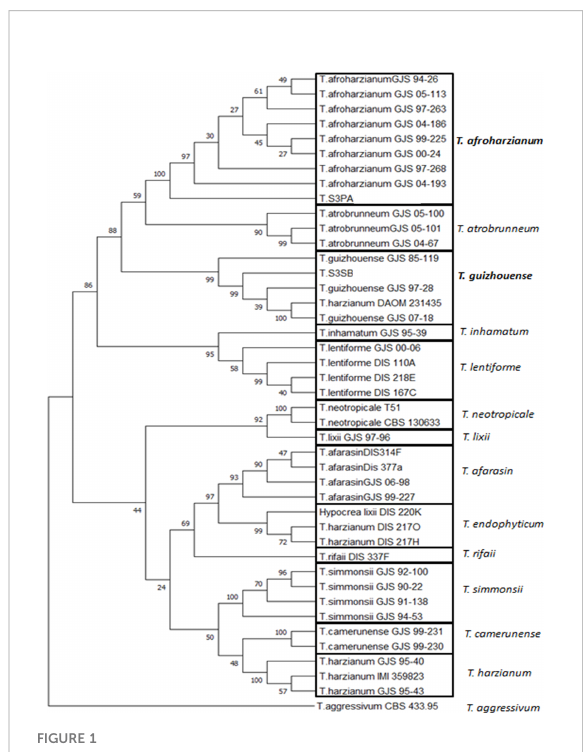
FIGURE 1 Phylogenetic tree of CAL-EF-ITS branch includes only species in the T. harzianum complex. Two species are identi fi ed from Lebanon and are placed in this tree: T. afroharzianum (T. S3PA) and T. guizhouense (T. S3SB). Strains used in this phylogenetic analysis are described in Supplementary Table 1 with their corresponding geographic origin, substrate, voucher number and GenBank accession numbers. T. agressivum is used as an outgroup in this